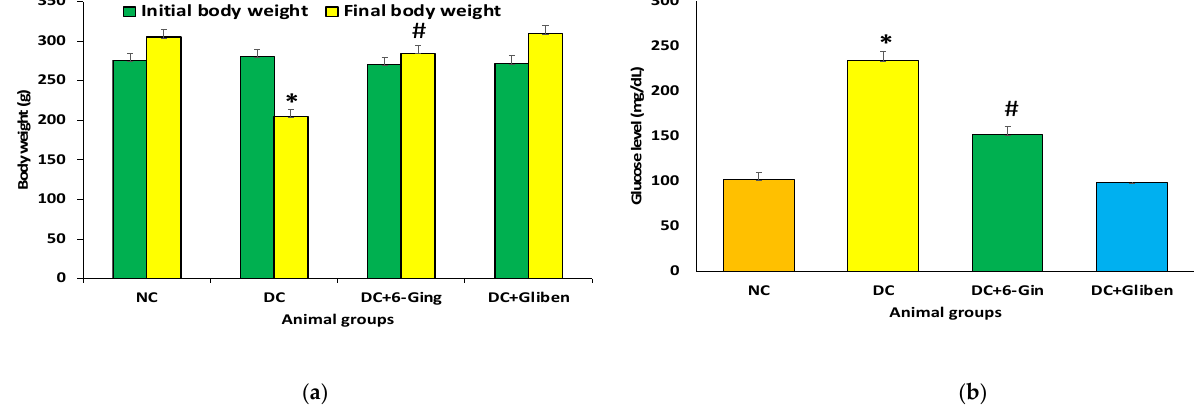
Figure 1. ( a ) The initial and the final body weight of different groups of rats after 8 weeks of experimental design. The rats were equally divided into 4 groups, each group ( n = 8). Data are represented as mean ± standard error of the mean (SEM). Groups: Normal control (NC); disease control (DC), i.e., STZ-treated group; treatment group (DC + 6-gingerol); positive control (PC) animal treated with STZ + glibenclamide; * p < 0.05 (significant difference of final b.w. between DC vs. NC) # p < 0.05 (significant difference of final b.w. between DC vs. DC + 6-gingerol). ( b ): The values of serum glucose in different groups of rats after 8 weeks of treatment. The rats were equally divided into 4 groups, each group ( n = 8). Data are repre-sented as mean ± standard error of the mean (SEM). Groups: Normal control (NC); disease control (DC), i.e., STZ-treated group; treatment group (DC + 6-gingerol); positive control (PC) animal treated with STZ + glibenclamide; * p < 0.05 (sig-nificant difference of final b.w. between DC vs. NC) # p < 0.05 (significant difference of final b.w. between DC vs. DC + 6-gingerol).